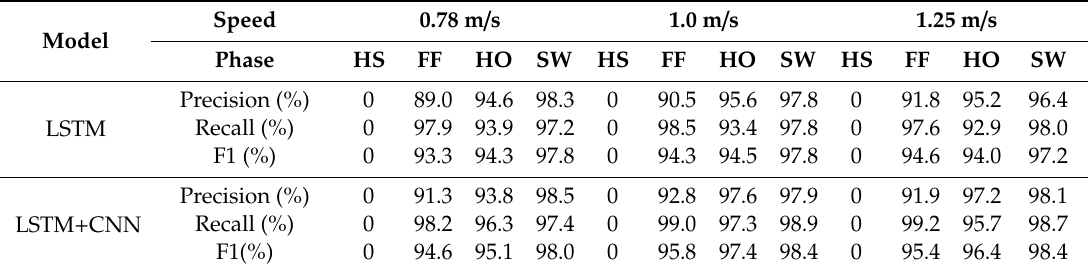
Table 2. Summary of classification performance of different models at unsynchronized speed.